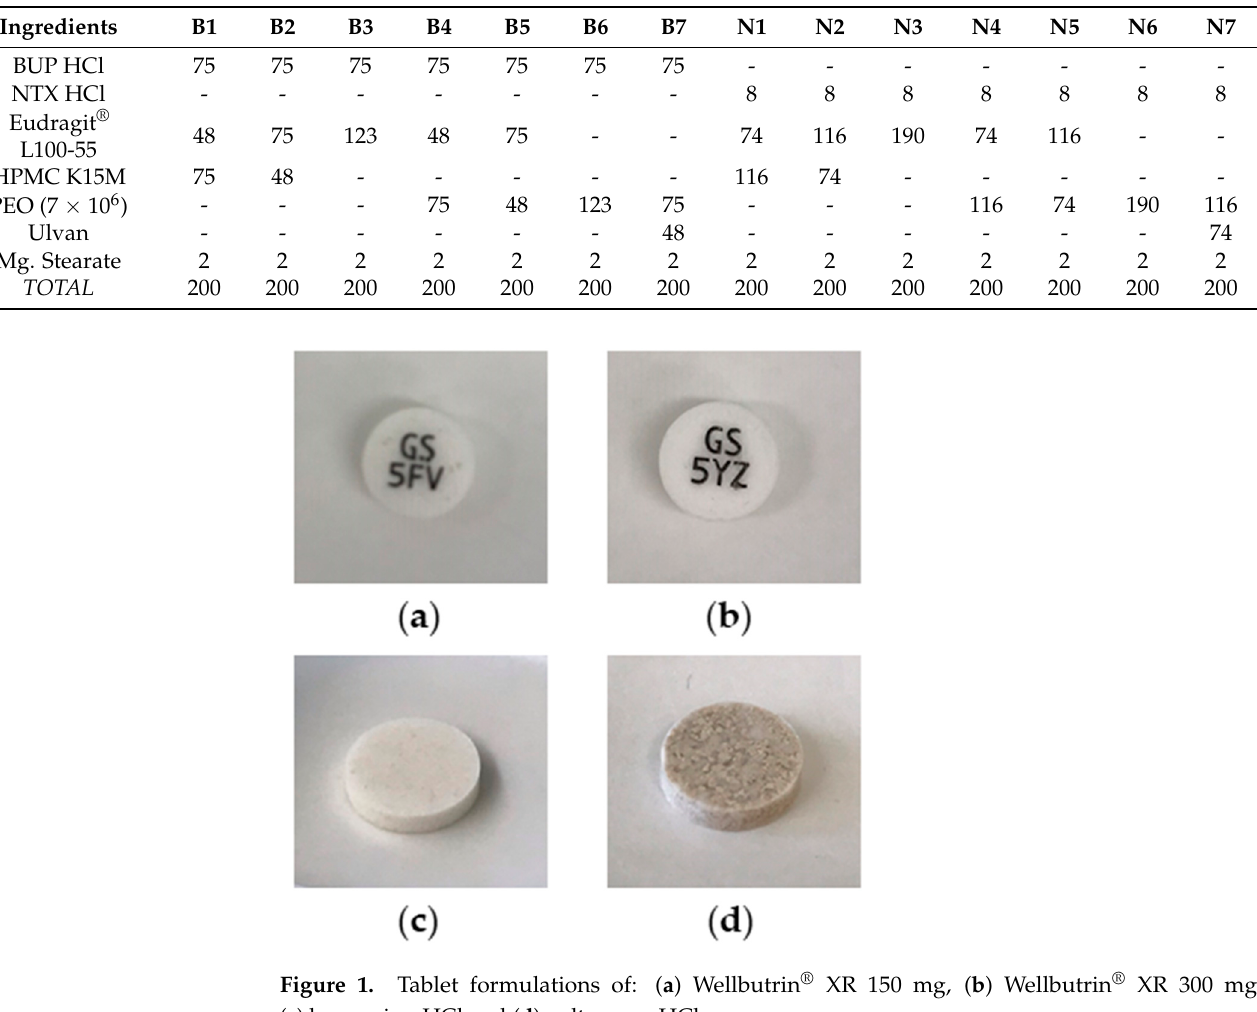
Table 1. Composition of BUP · HCl and NTX · HCl tablet formulations (mg).